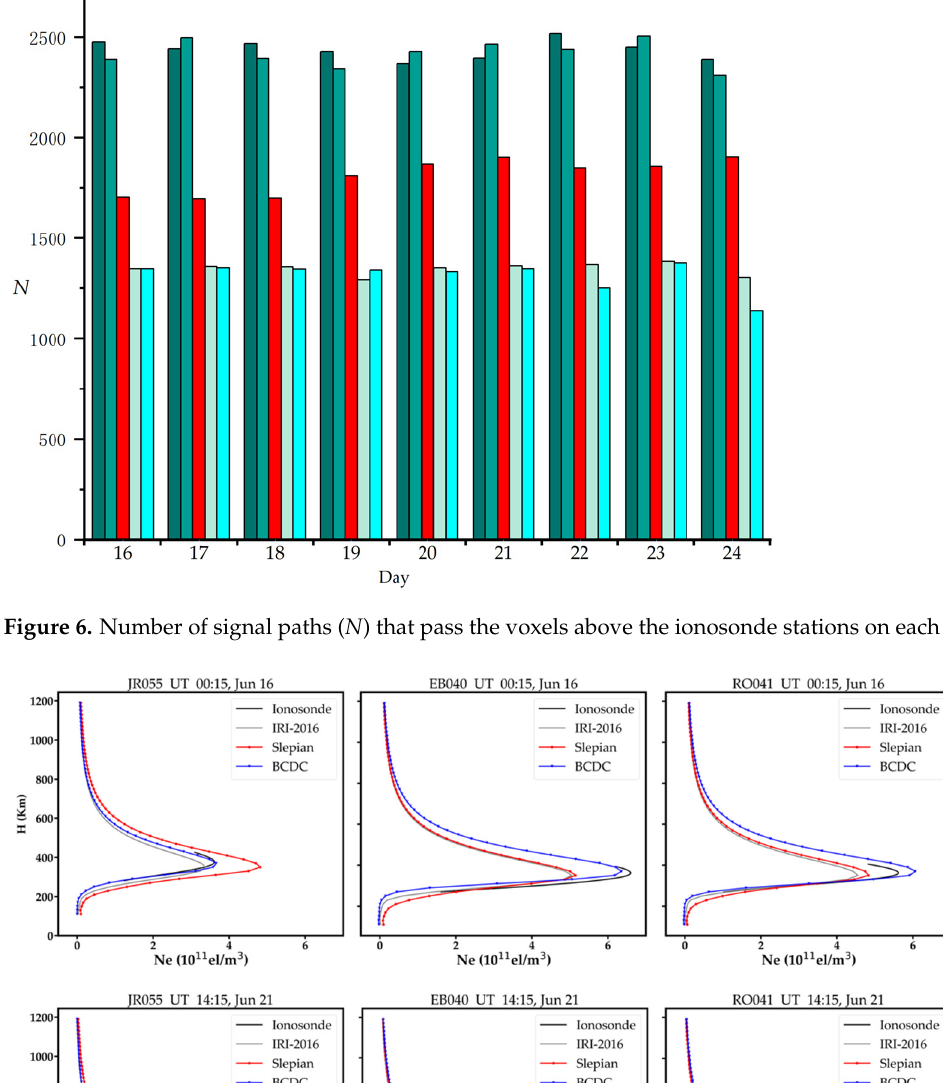
Figure 7. Vertical profiles obtained by the BCDC method, the Slepian method and the IRI − 2016 model against those observed at JR055, EB040 and RO041 stations during the geomagnetic quiet time.